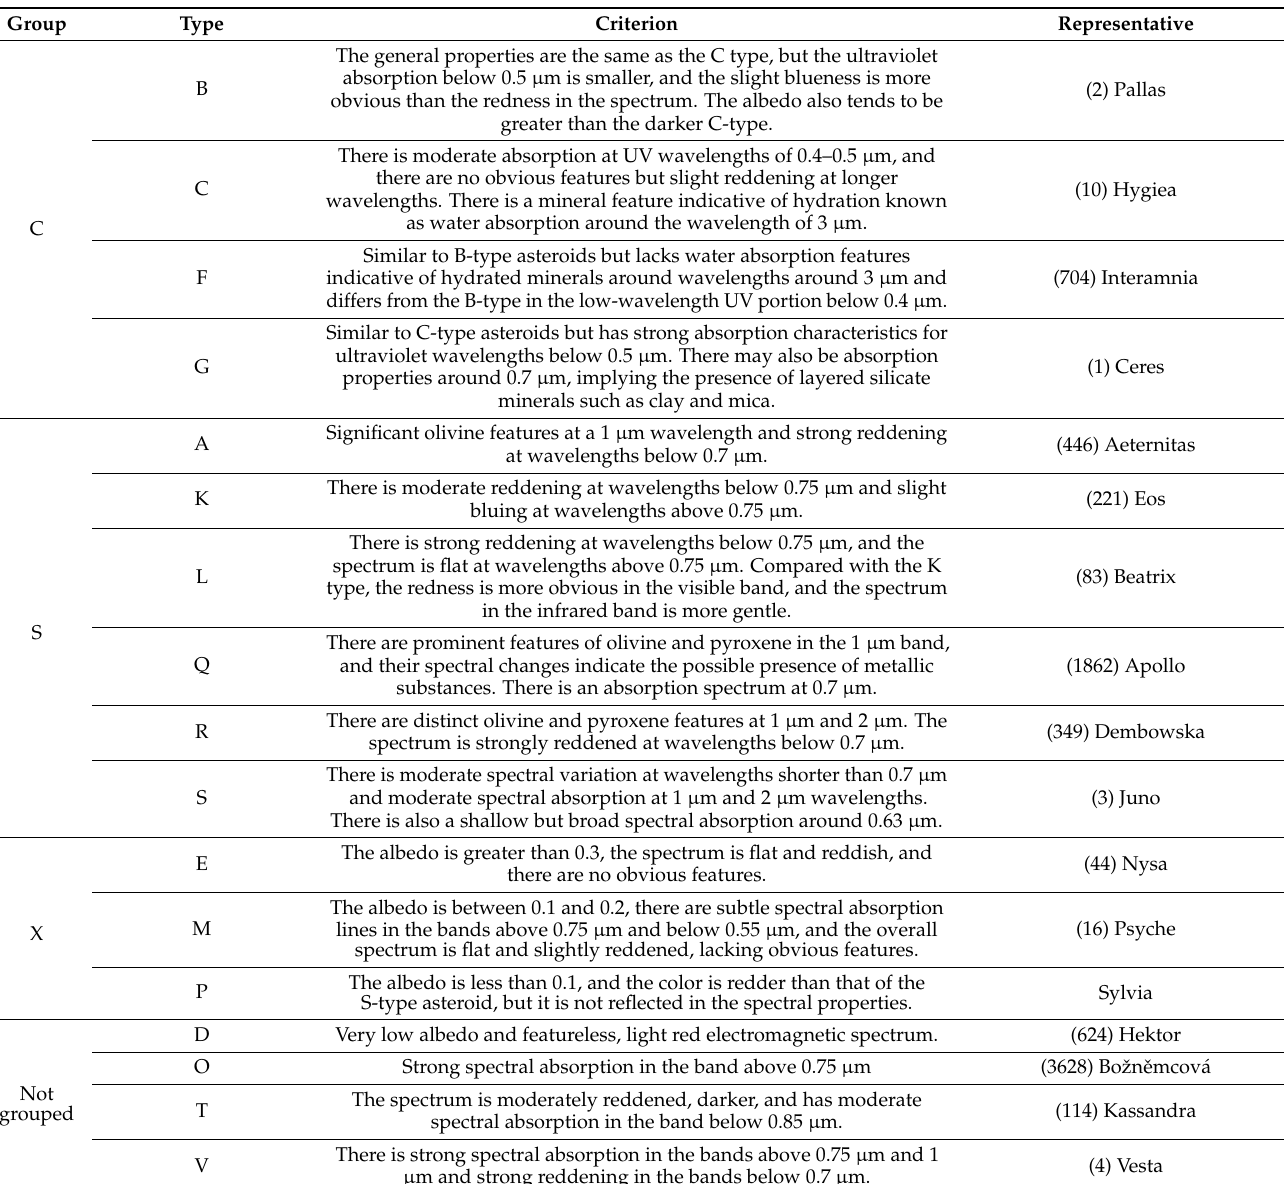
Table 2. Spectral Classification of